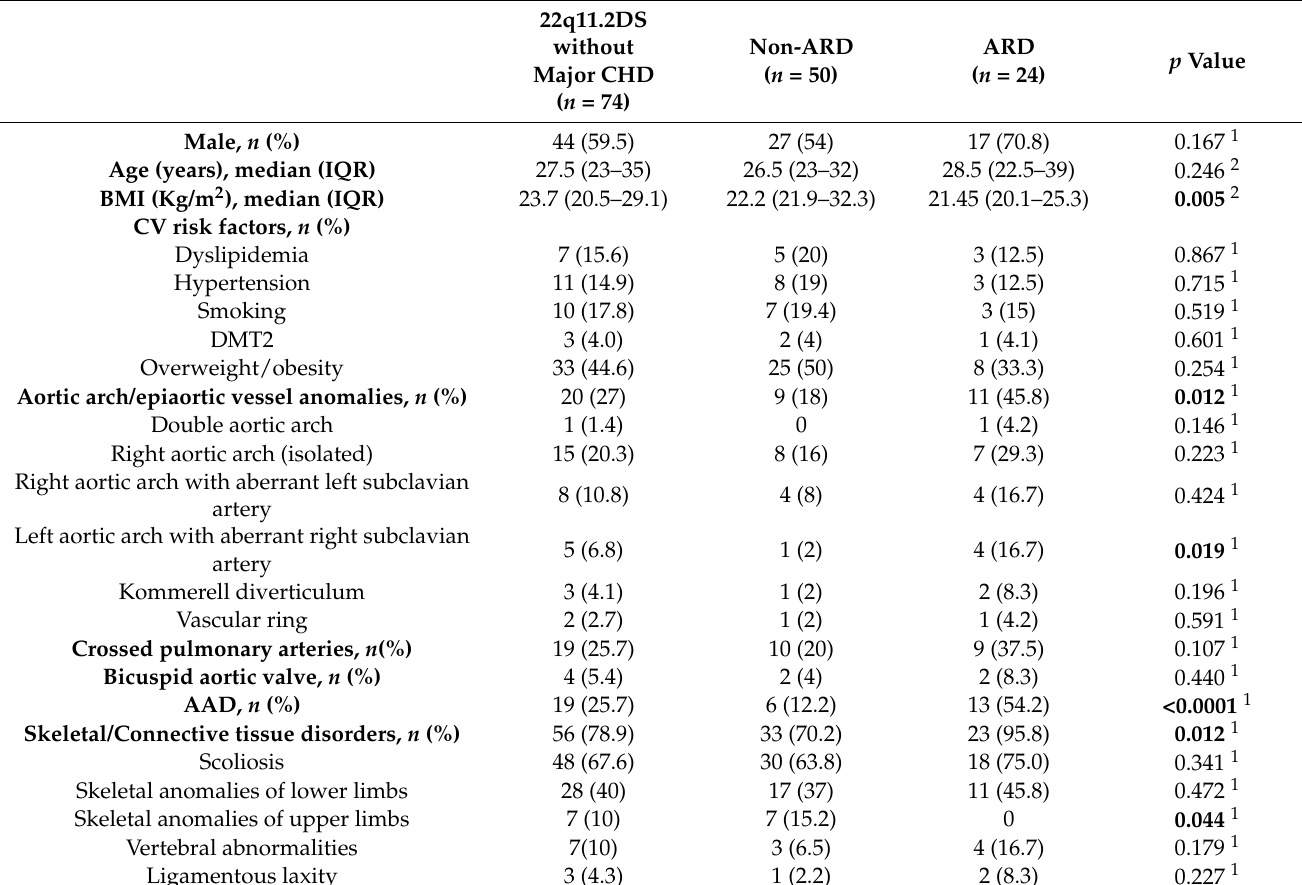
Table 1. Patients’ characteristics at enrollment.